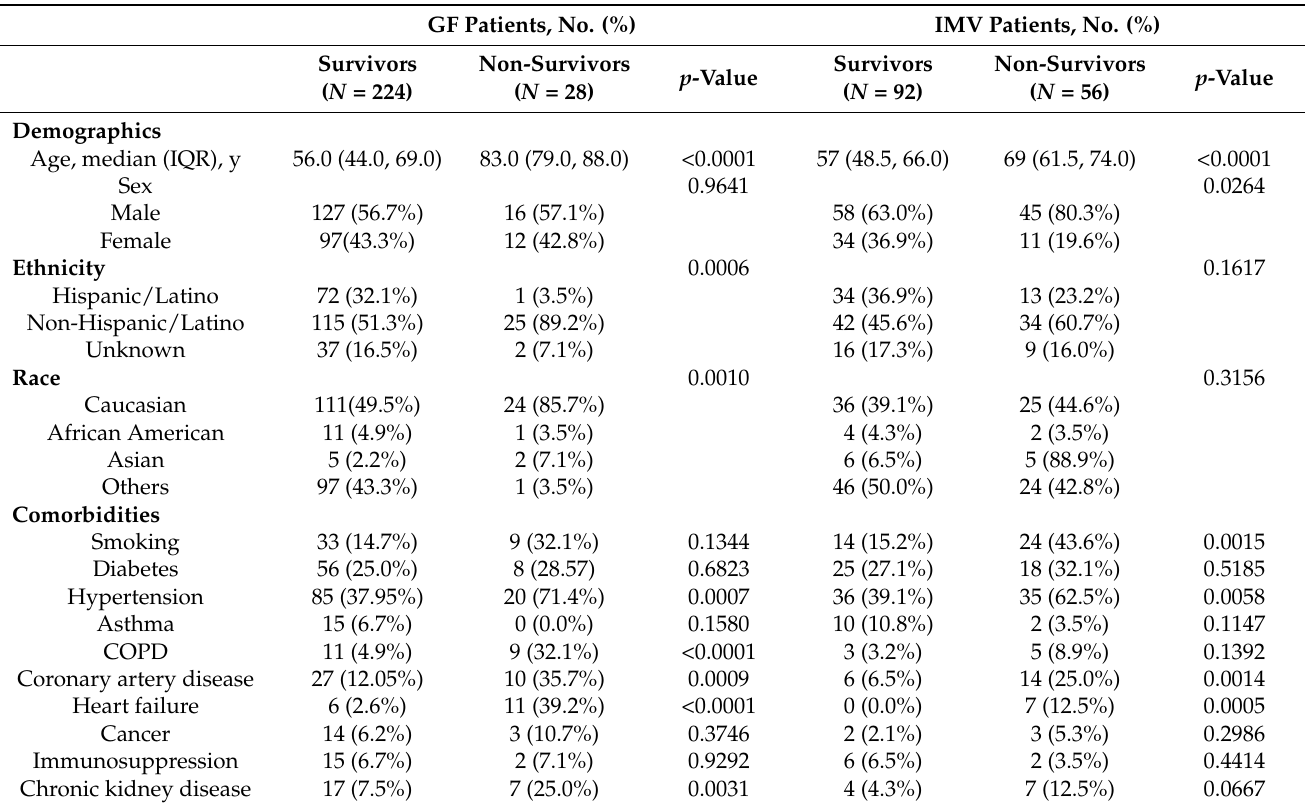
Table 1. Demographic characteristics and comorbidities. (A) General floor (GF) group, and (B) invasive mechanical ventilation (IMV) group, separated by survivors and non-survivors. Group comparison of categorical variables in frequencies and percentages used chi-squared or Fisher exact tests. Value inside parentheses indicate %, except for age which indicates